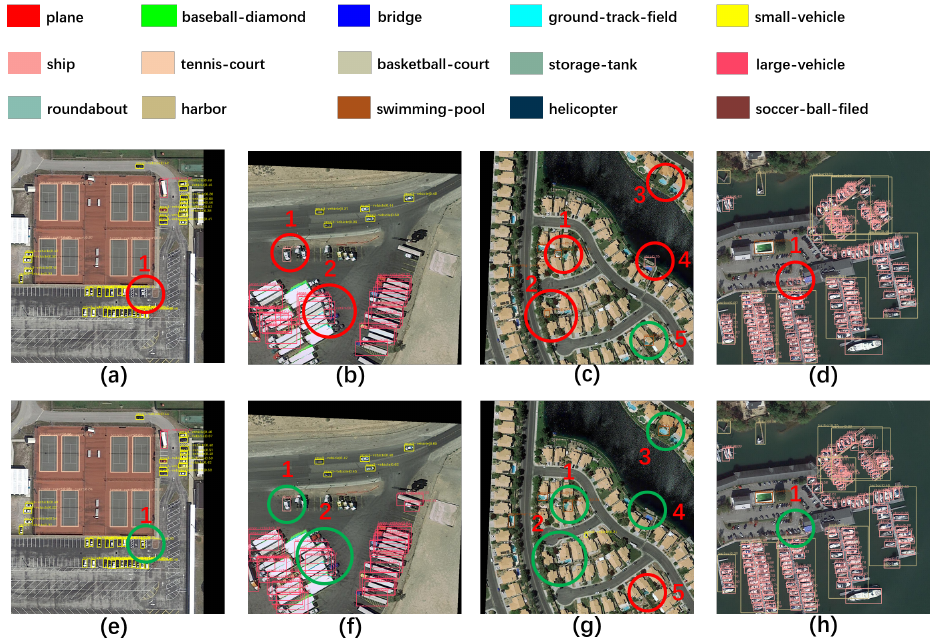
Figure 8. The visualization comparison between the baseline method and the proposed RelationRS in this paper. The first line ( a – d ) is the visualization of the baseline inference result, and the second line ( e – h ) is the visualization of the RelationRS inference result. Each column represents the detection results of two algorithms in the same scene, where the red circle represents the failure case in the column, and the green circle represents the better case in the column. Circles with the same number in the same column form a contrasting